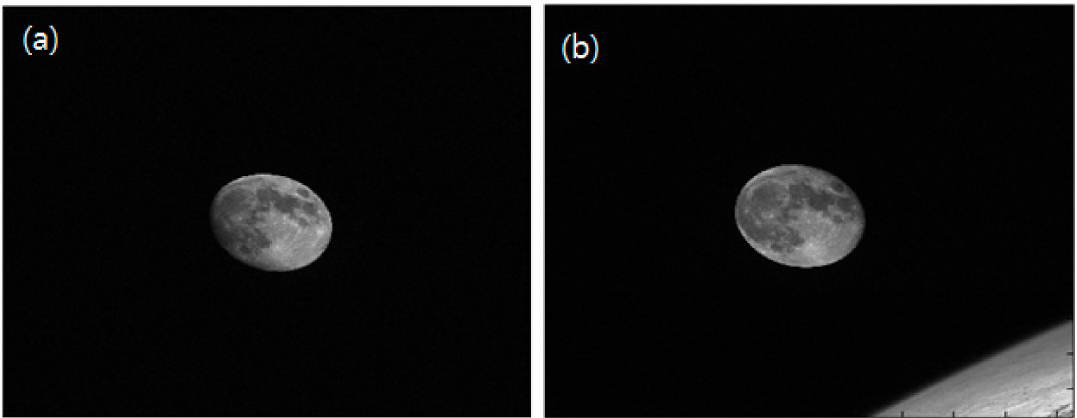
Figure 1. Level 1A (Local Area (LA) mode) Moon observation data ( a ) Normal Moon observation data ( b ) Moon image with Earth on the edge of LA Image (1–2 times